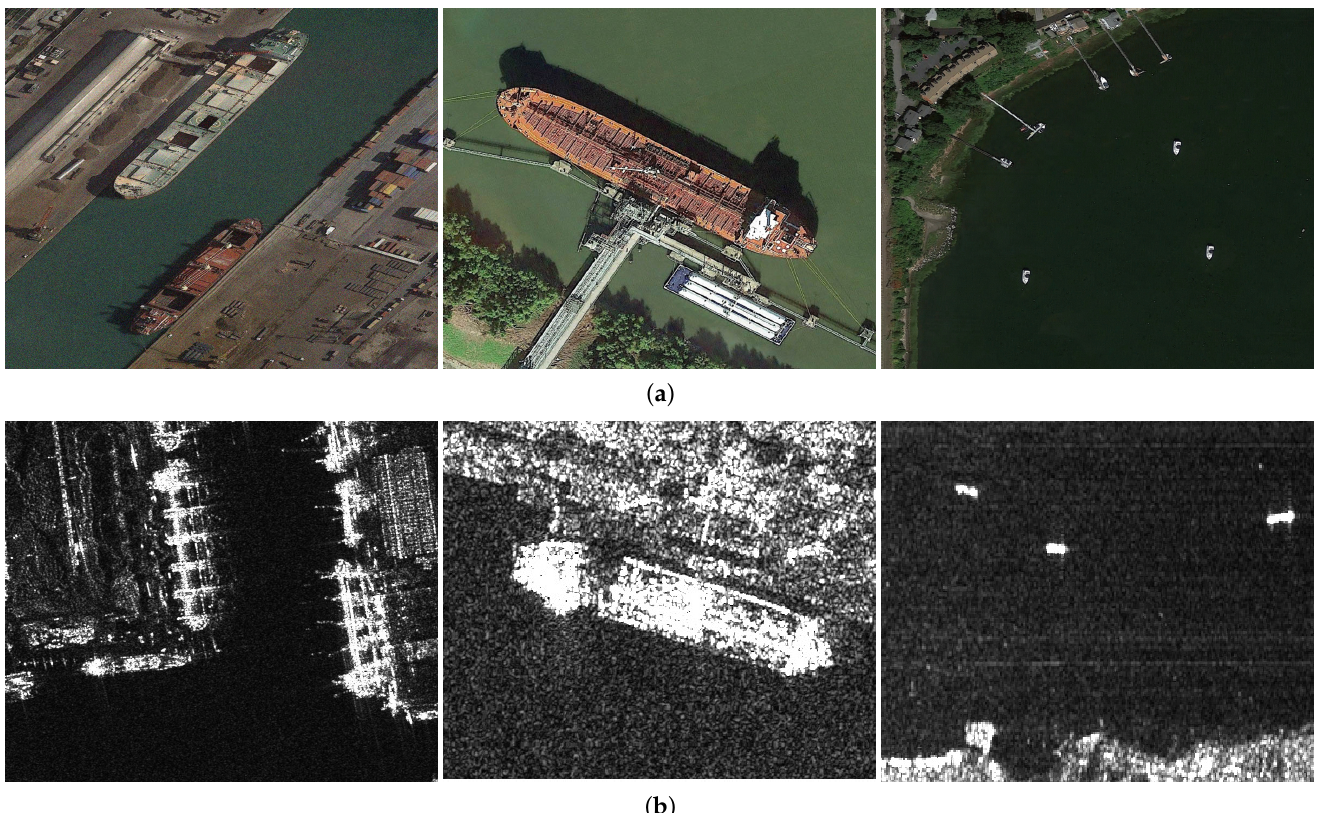
Figure 1. Comparison of optical images and SAR images. There is a large domain shift between the optical images and the SAR images, but ship targets present the same shape characteristics in the optical and SAR images. ( a ) Optical images. ( b ) SAR